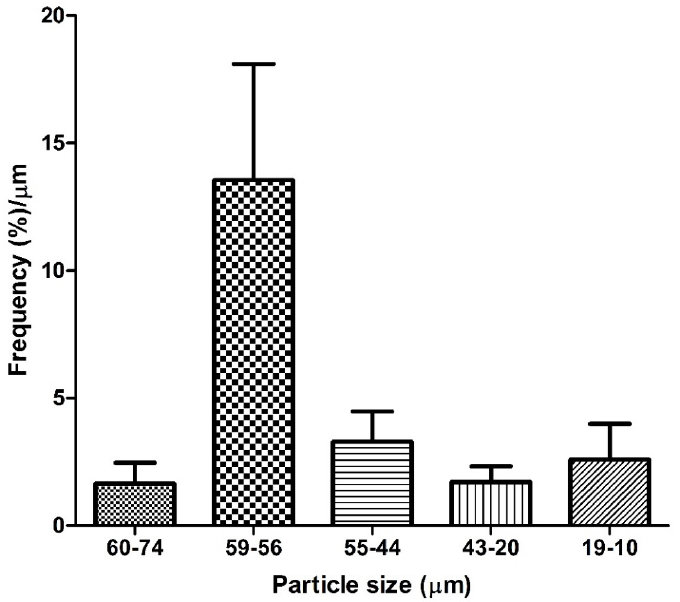
Figure 5. Distribution of particles removed from CAFs collected.